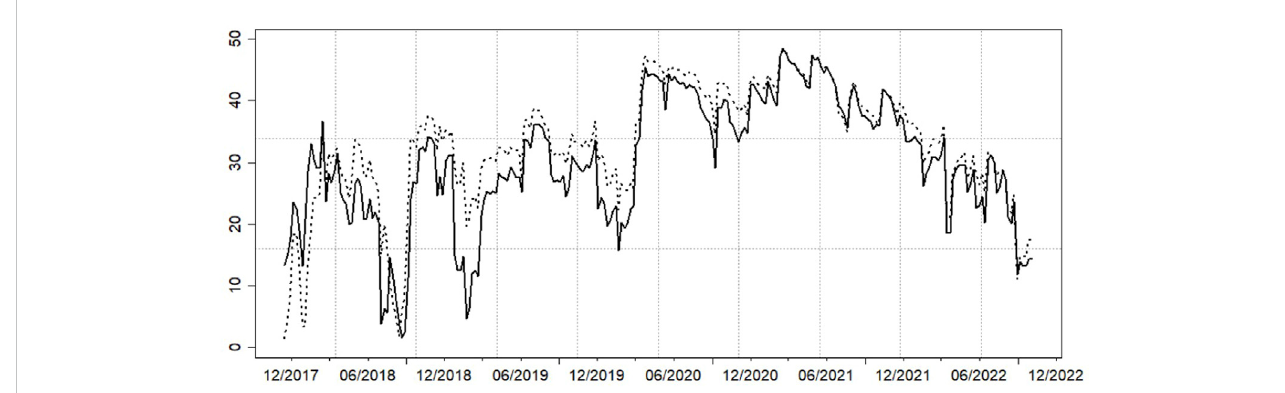
FIGURE 11 Comparison between total volatility connectedness of baseline estimation and estimation with a smaller